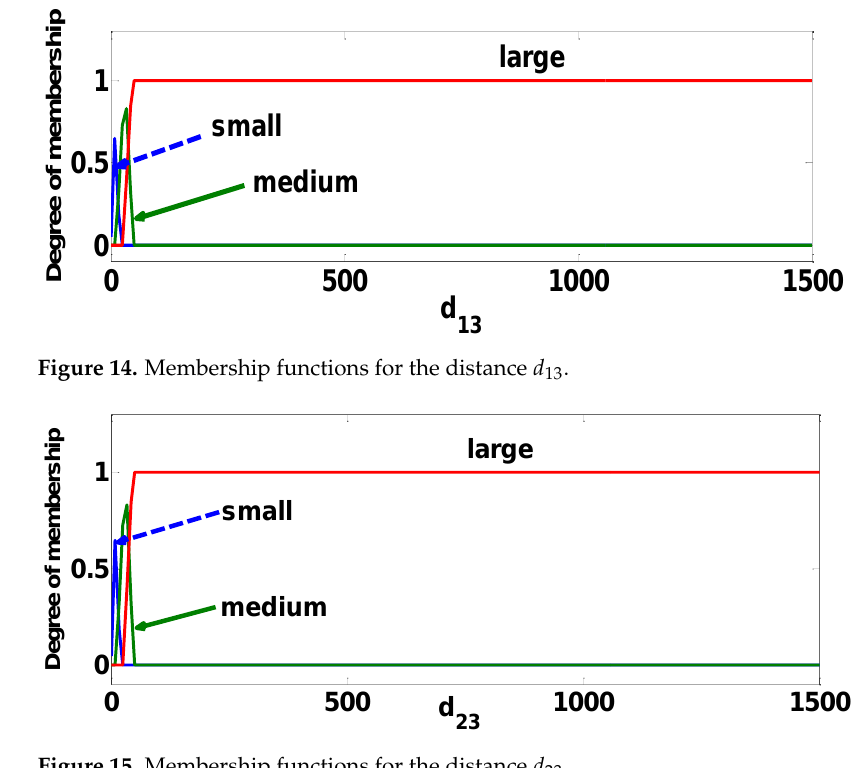
Figure 15. Membership functions for the distance 𝑑 23 .